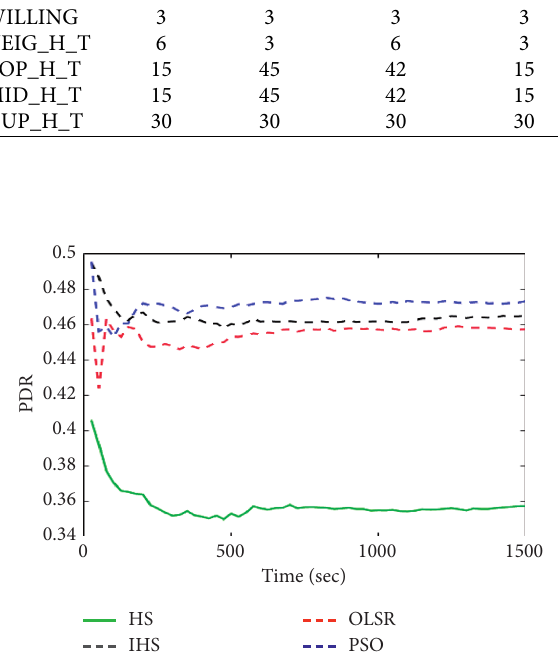
Figure 8: PDR simulation